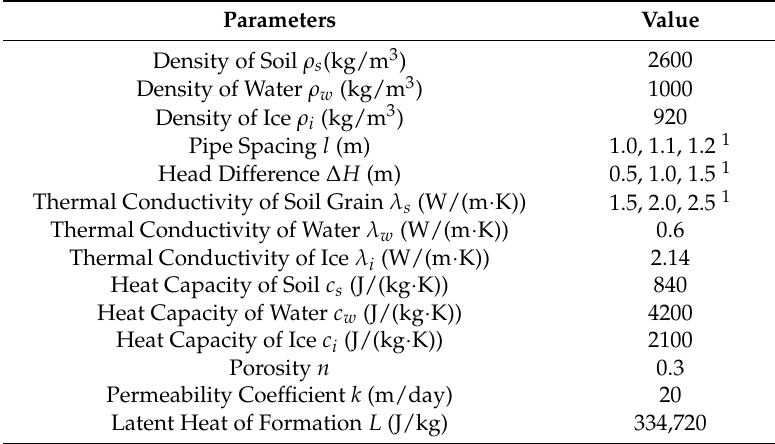
Figure 5. The temperature distribution results of parametric sweep experiments.